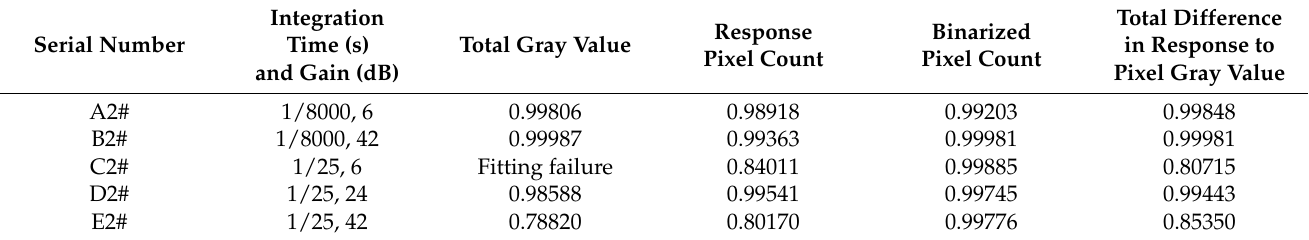
Table 6. Error analysis of fitting results of feature values in dark area of color